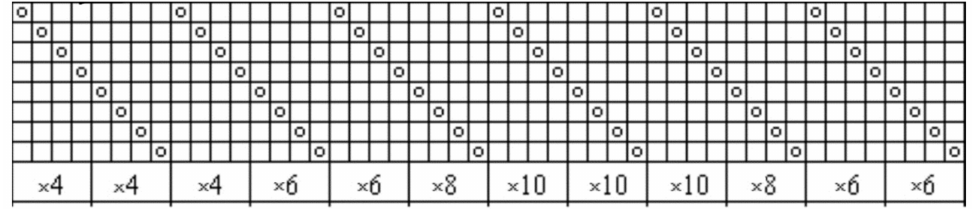
Figure 1. Drawing-in scheme of the woven fabric. The fabrics were treated with different finishings. At first, grey fabrics and dyed fabrics without any additional finishing operations were investigated. After this, grey and dyed fabrics after singeing were analyzed. Two types of printed fabric (pigment and reactive printing) were also